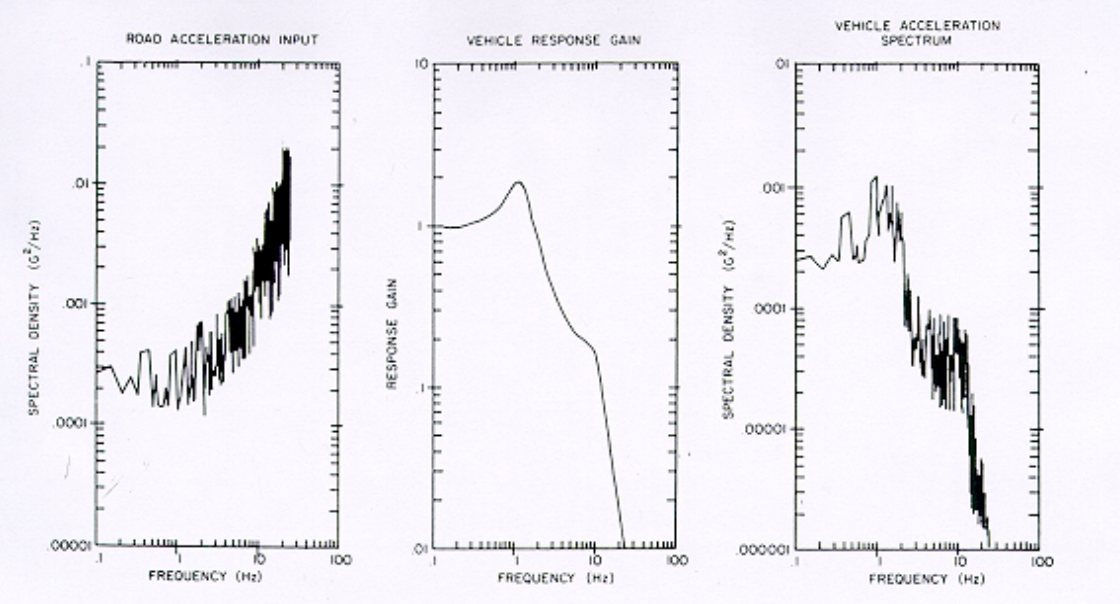
Fig. 1. Power spectral density after seat suspension